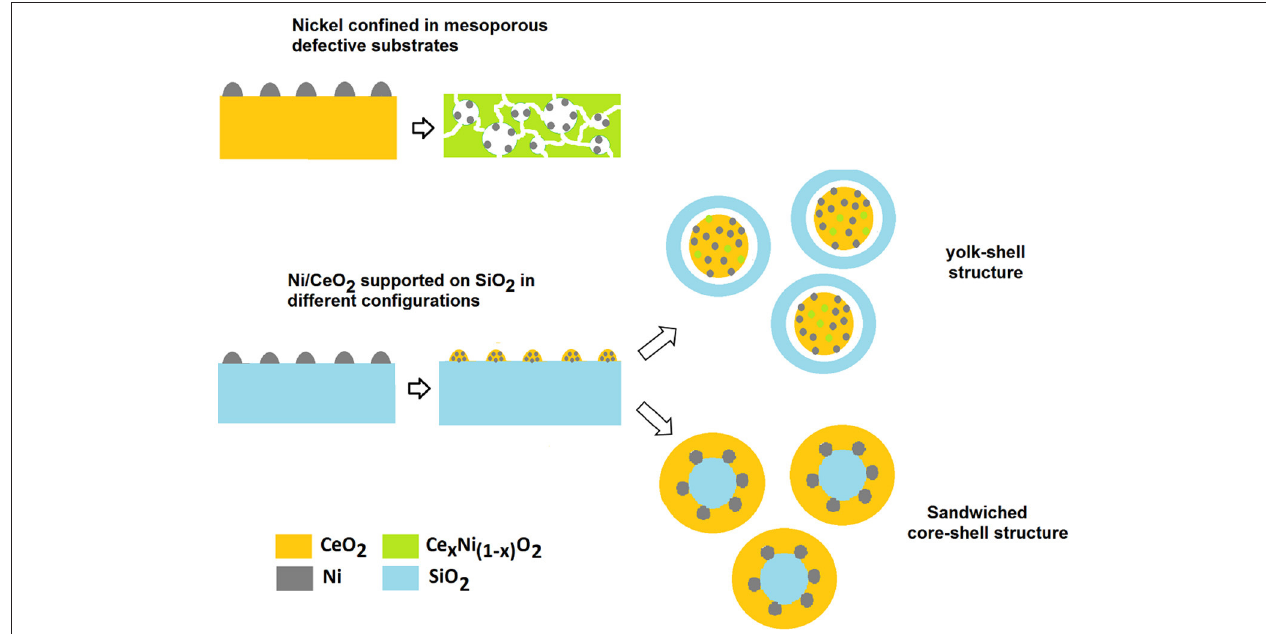
FIGURE 6 | Strategies to stabilize and activate Ni/CeO 2